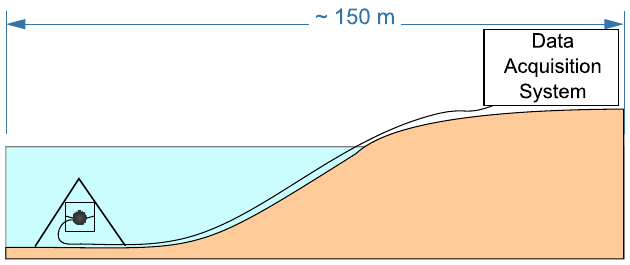
Figure 13. Scheme of the combined receiver installation by the bottom of Mikizha lake